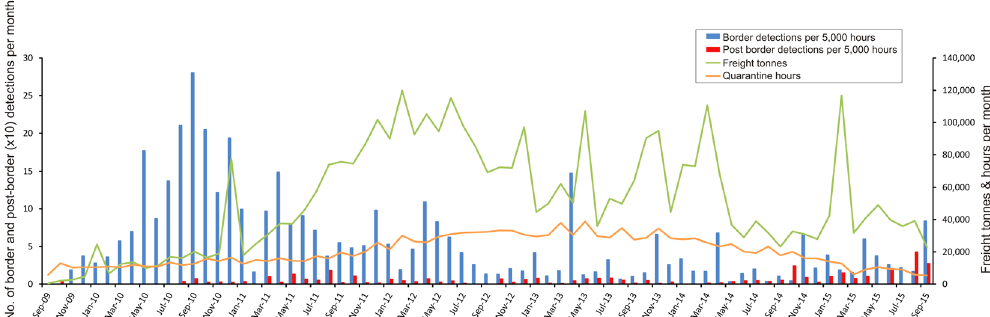
Figure 4. The patterns of quarantine hours, freight tonnage and corresponding border and post-border detections of Non Indigenous Species over the surveillance period. The most compelling correlations are between freight tonnes per month and border detections in the same month (Pearson’s r = 0.65, p < 1E-9), and between freight tonnes per month and quarantine hours in the subsequent month (r = 0.59, p < 1E-5). Correlations that were statistically significant but of smaller magnitude were found between quarantine hours per month and post-border detections in the same month (r = 0.26, p = 0.024) or in the subsequent month (r = 0.27, p = 0.021). Overall, there was an increase of 17.6 quarantine hours (s.e. = 2.5 hours) for every